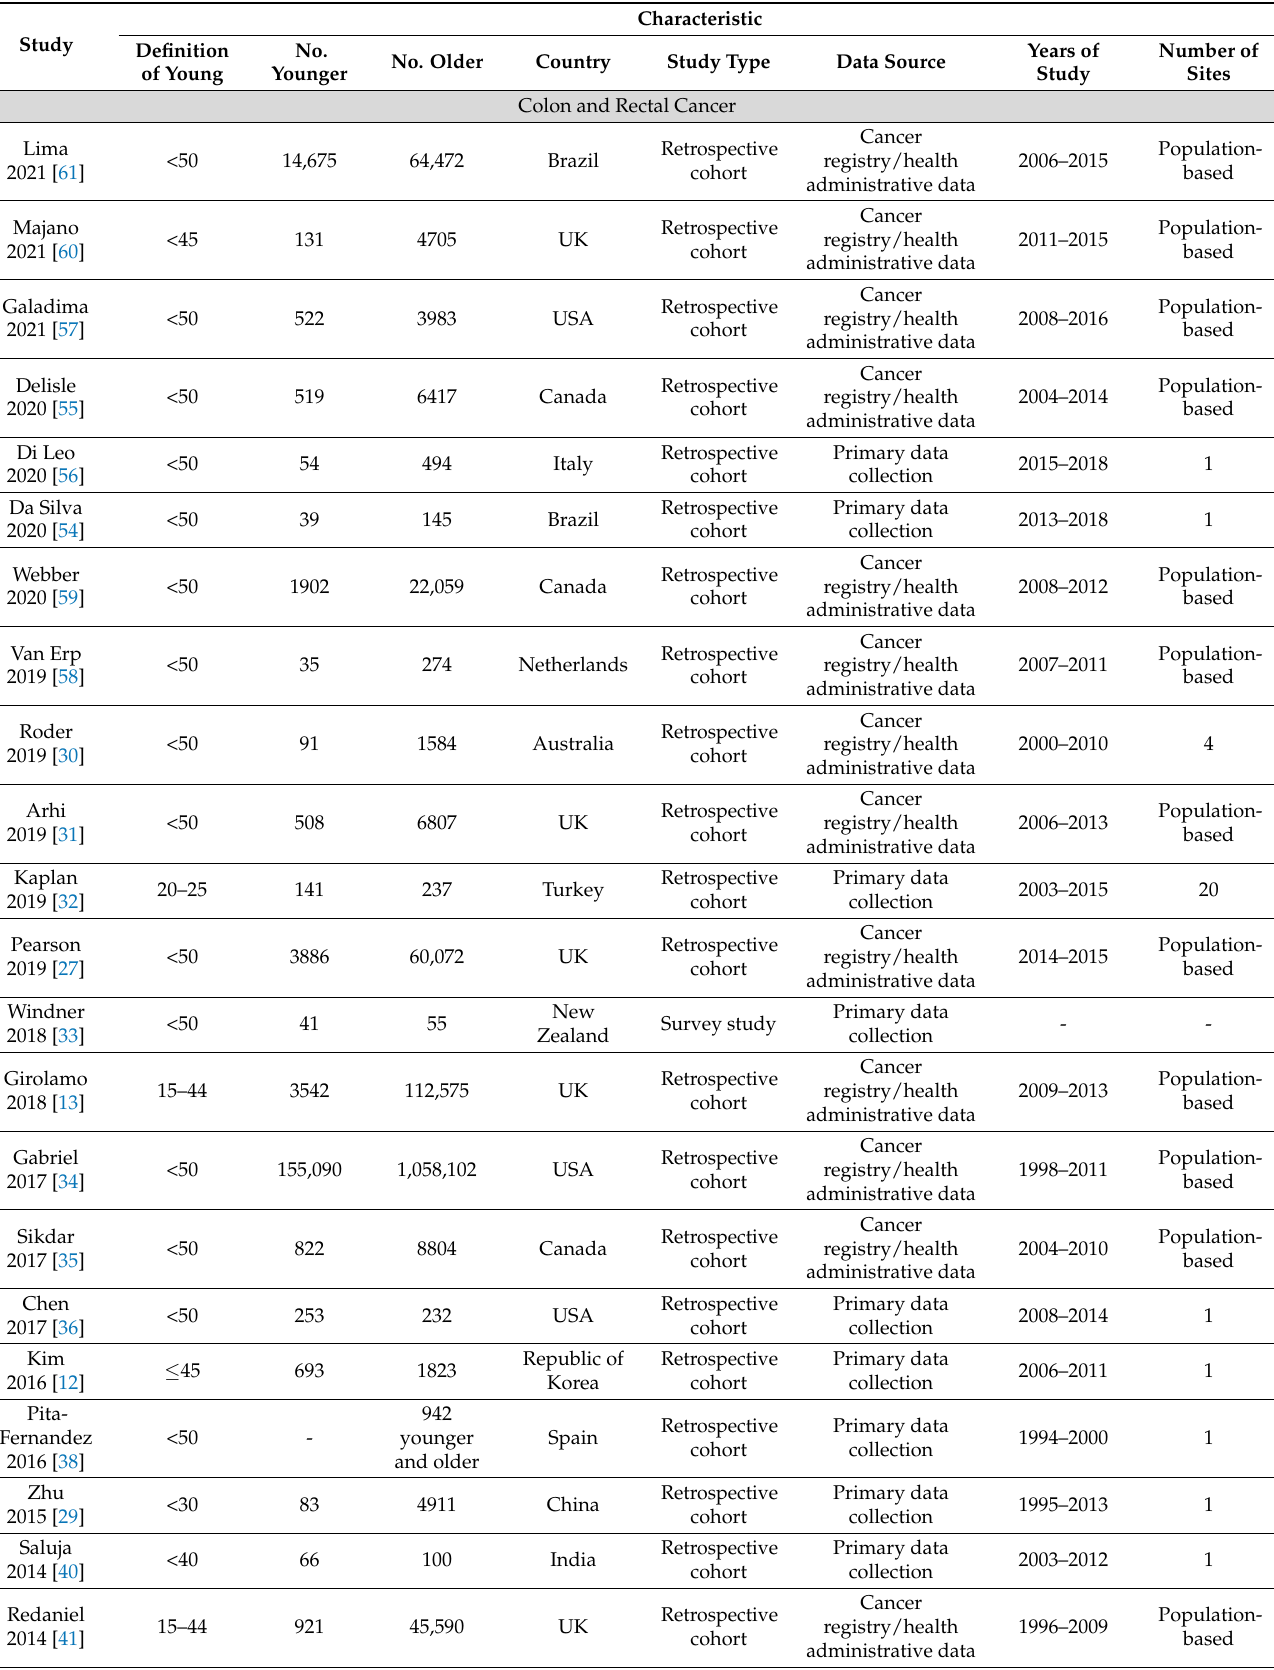
Table 1. Characteristics of included studies ( n = 39)